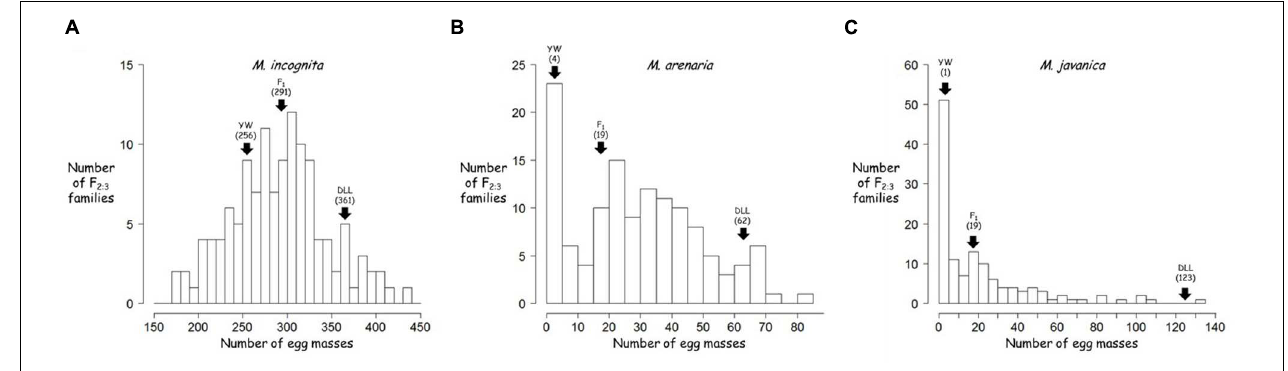
FIGURE 2 | Frequency distribution of the resistance to different root-knot nematode (RKN) species of the pepper F 2 : 3 families: (A) M. incognita ; (B) M. arenaria ; and (C) M. javanica . Arrows indicate the position of each parent and the F 1 in the phenotypic distribution, with their values indicated in brackets. YW, Yolo Wonder; DLL, Doux Long des Landes; F1, (YW × DLL). TABLE 1 | Summary of root-knot nematode (RKN) reproduction capacity in the parental lines, F1 and F 2 : 3 progeny (130 F 2 : 3 families) from the pepper cross (YW × DLL), for different RKN species. RKN species Parents F 1 F 2 : 3 families YW DLL Maximum Minimum Mean SD h 2 250 330 319 0.48 Meloidogyne javanica